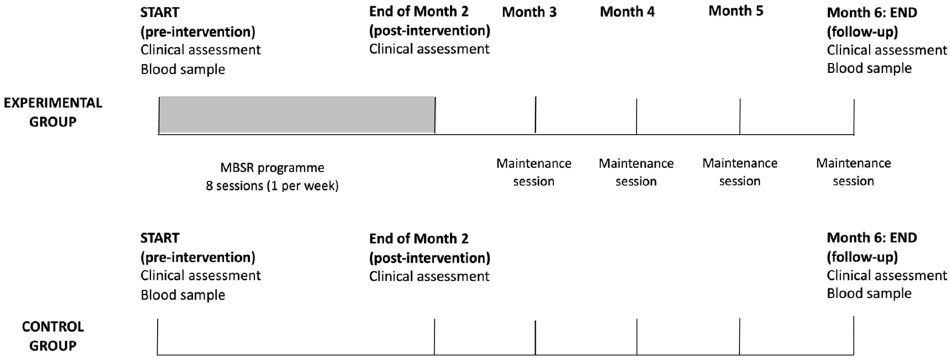
Figure 1. Study Figure 1. Study design.